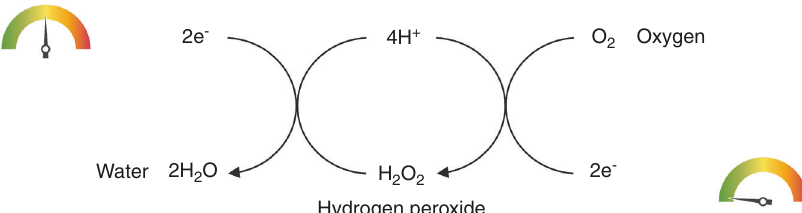
Fig. 8 The two-step reduction of oxygen allows the formation of hydrogen peroxide as a detectable intermediate